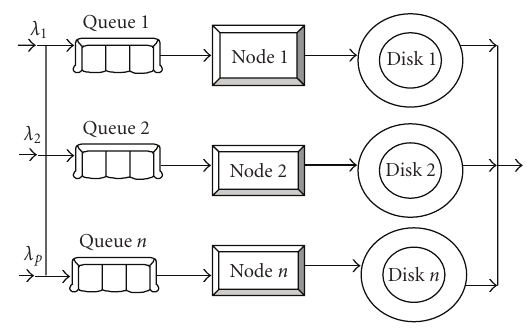
Figure 1: A Structure of queuing